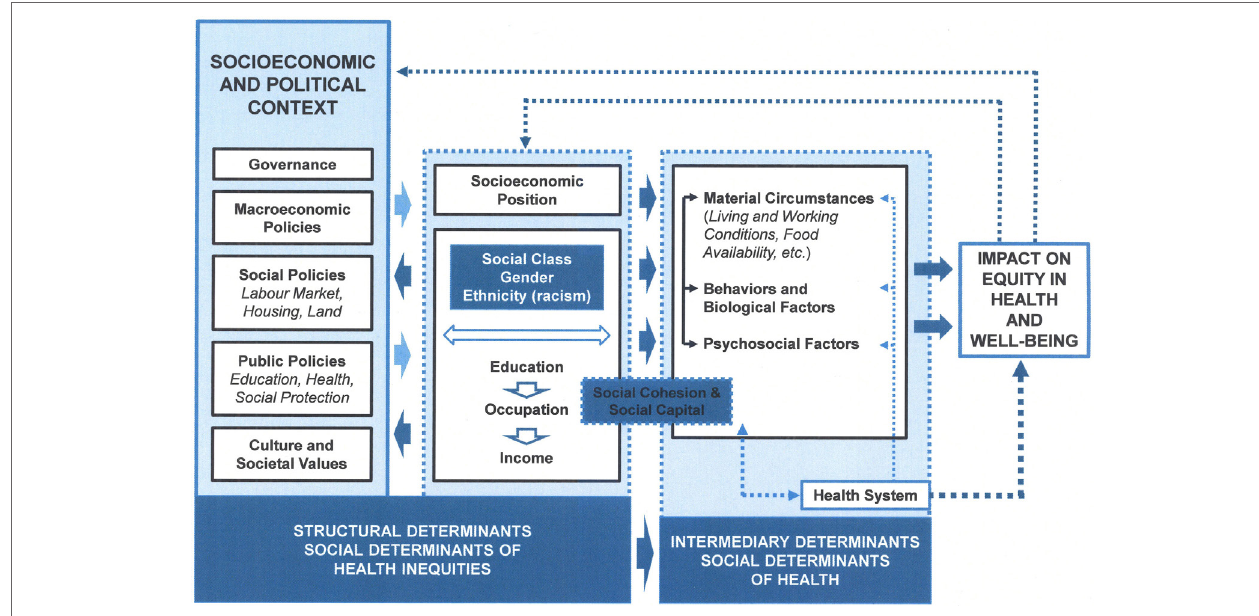
FiguRe 1 | The Commission on Social Determinants of Health conceptual framework